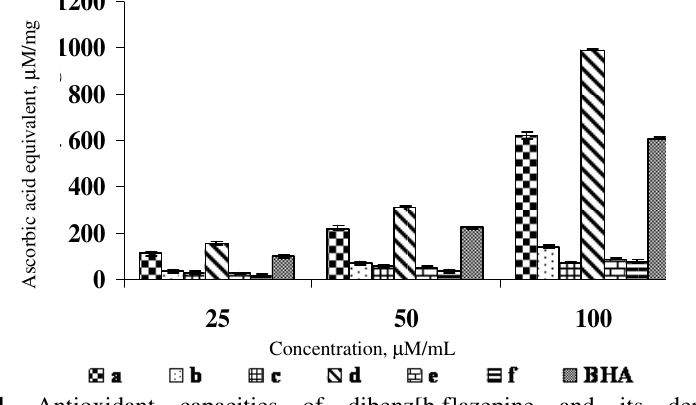
Figure 4 . Antioxidant capacities of dibenz[b,f]azepine and its derivatives by phosphomolybdate method. Each value represents means ± SD